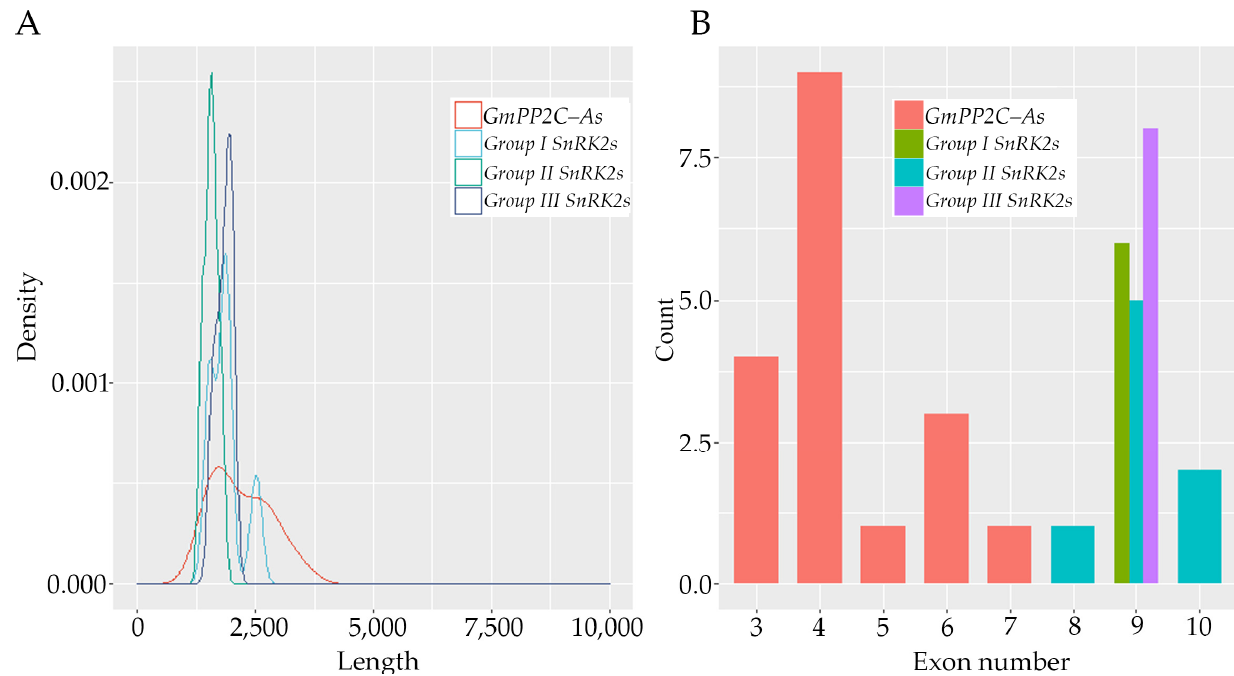
Figure 3. Length distribution ( A ) and exon numbers ( B ) of GmPP2C-A and GmSnRK2